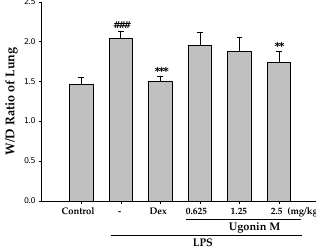
Figure 4. Effect(s) of Ugonin M on pulmonary edema. The right lower lungs were used to assess the W/D ratio of lungs. Each value represents the mean ± SD of six mice. ### p < 0.001 was compared with a sample of the control group (one-way ANOVA followed by Scheffe’s multiple range tests). ** p < 0.01 and *** p < 0.001 were compared with the LPS-only group.